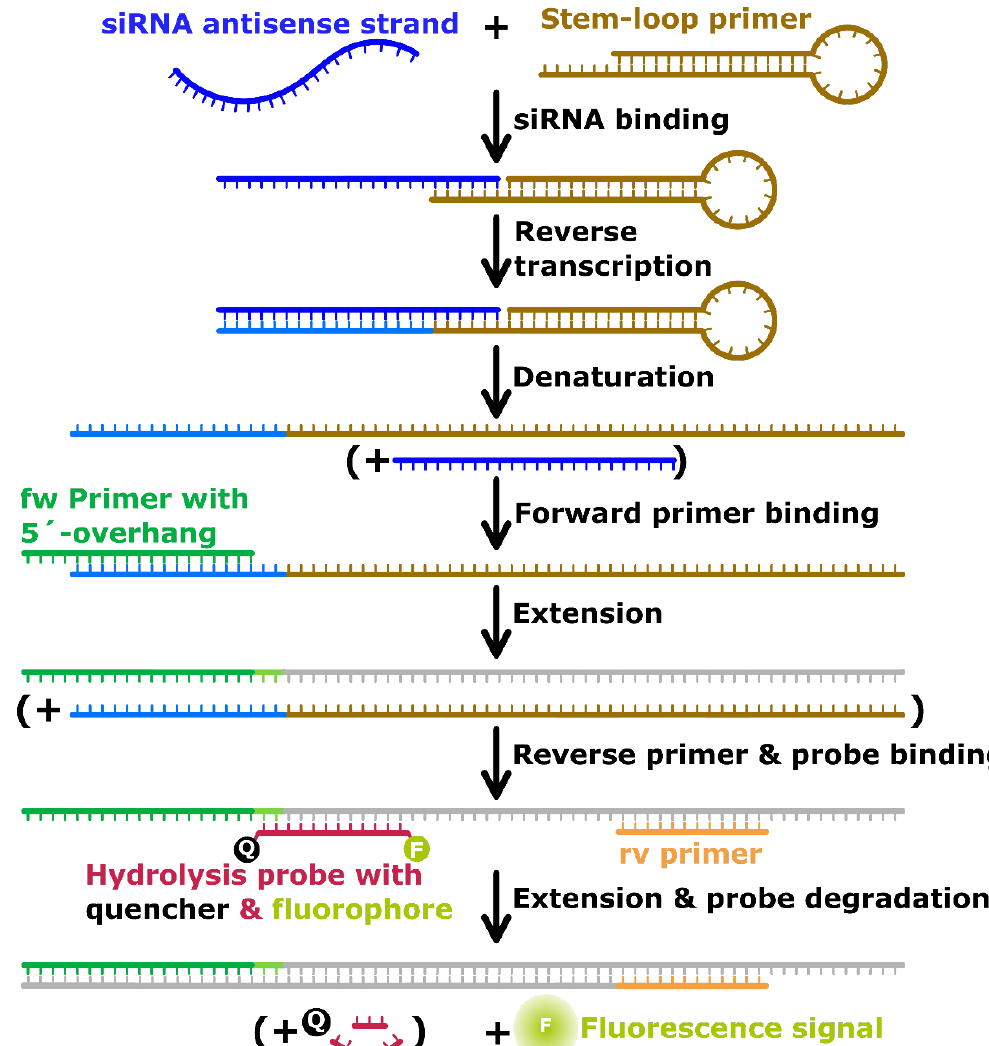
Figure 2. Mechanism of siRNA reverse transcription, amplification and detection via stem-loop primer and fluorescently labeled hydrolysis probes. Method adapted from Chen et al. [23] and Kramer [47]. fw primer: forward primer; rv primer: reverse primer; Q: quencher; F: fluorophore.